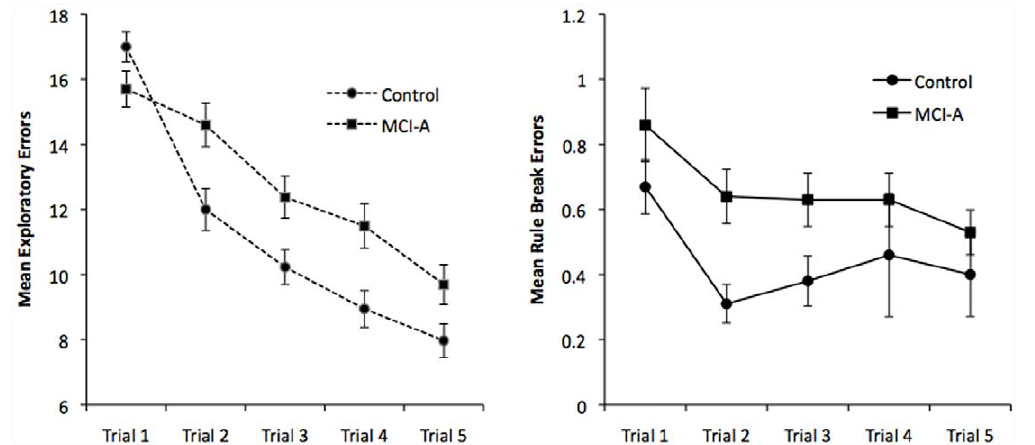
Figure 2. Mean Exploratory Errors and Rule Break Errors (with Standard Errors) over five learning trials of the Groton Maze Learning Test in Healthy Controls versus aMCI groups.